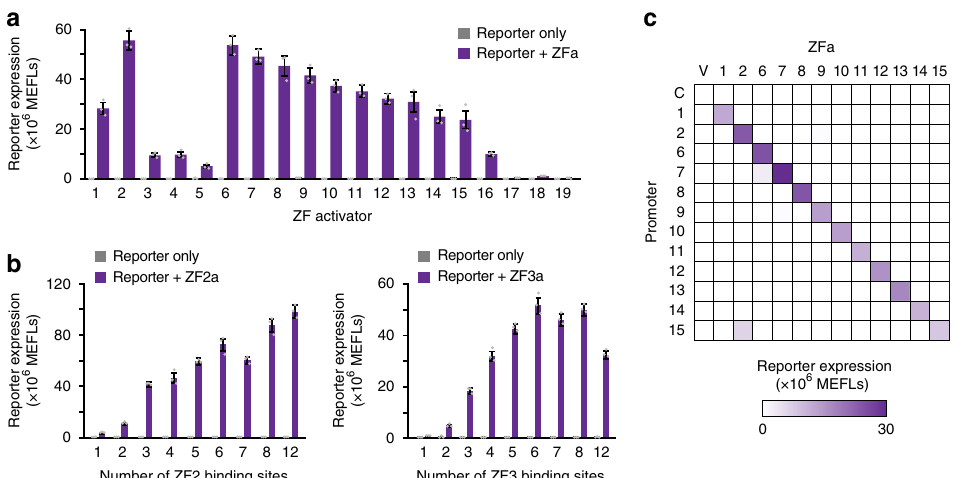
Fig. 3 Characterizing an expanded panel of ZFa. a Nineteen ZFa were paired with cognate x6-C promoters, and all signi fi cantly induced gene expression (one-tailed Welch ’ s t -test all p < 0.02). b ZFa-induced gene expression increased with the number of binding sites, on compact promoters, for ZF2 (ANOVA p < 0.001) and ZF3 (ANOVA p < 0.001). c Investigating the orthogonality between the 12 strongest ZFa using x6-C promoters. Abbreviations: V (Vector control, no ZFa gene), C (Control reporter, no ZF binding sites). Experiments were conducted in biologic triplicate, and data were analyzed as described in Methods. Error bars represent the S.E.M. Source data are provided in the Source Data fi